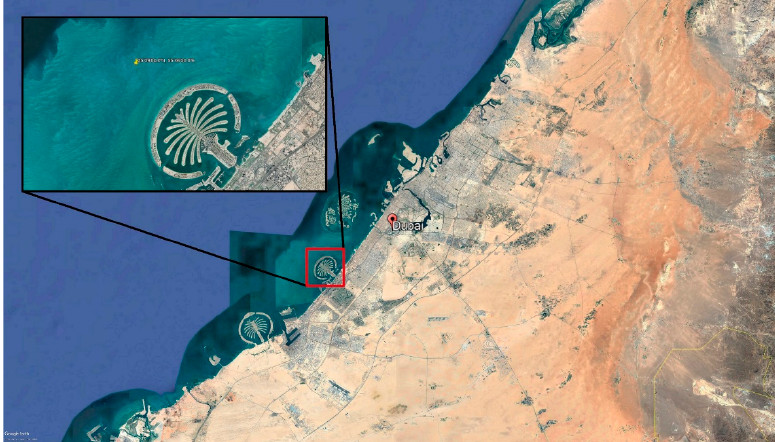
Figure 1. Location of the study point (25°09’00.0” N, 55°06’00.0” E).